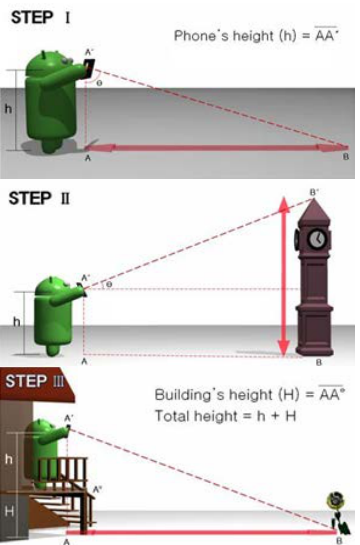
Figure 2. The process of using Smart Measure App. (Google